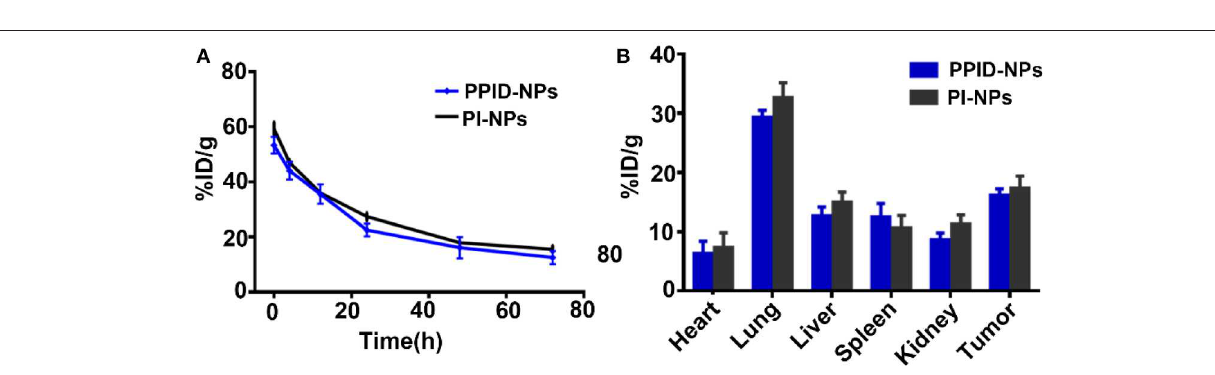
Frontiers in Chemistry |